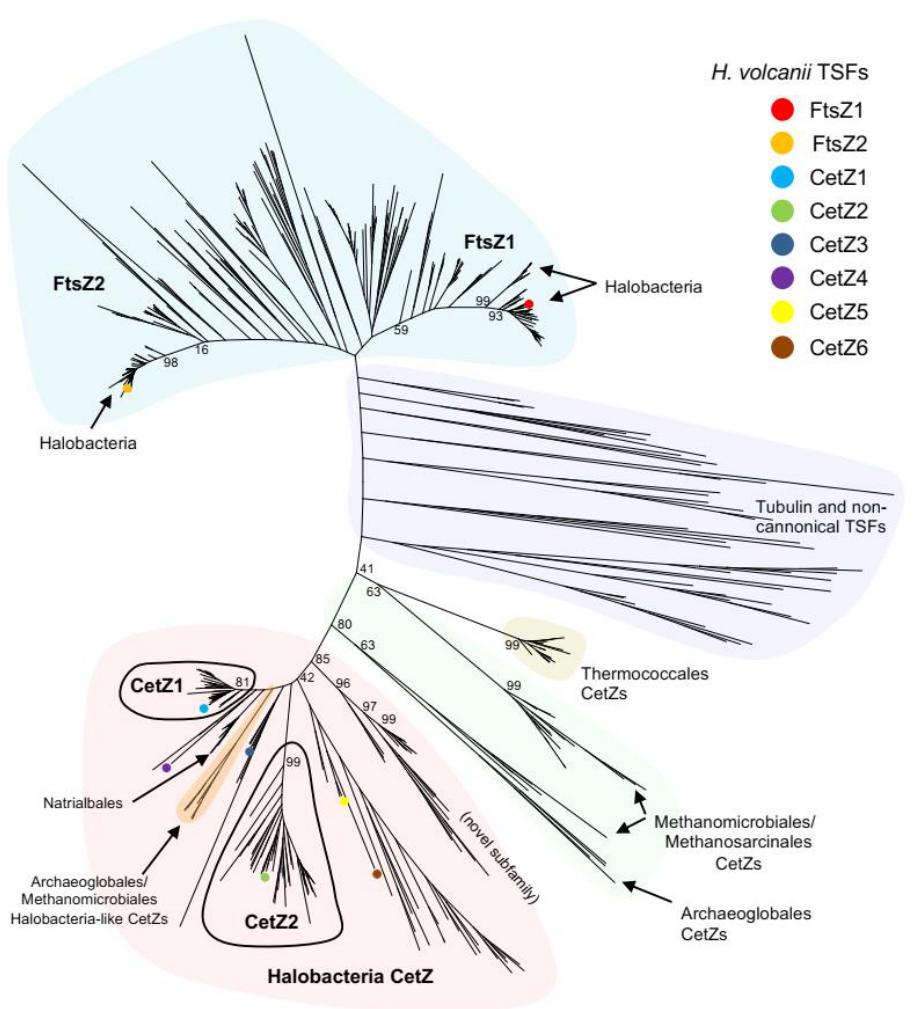
Figure 1. Phylogram of archaeal tubulin superfamily proteins; 550 identified tubulin superfamily protein sequences from 183 diverse archaea were aligned to generate the phylogram. Archaeal FtsZs are shaded in blue, while tubulin and non-canonical TSFs are shaded in purple. Four main groups of CetZs were identified: Halobacteria CetZs (red); Halobacteria-like CetZs from Archaeoglobales and Methanomicrobiales (orange); non-Halobacteria-like CetZs from Archaeoglobales, Methanomicrobiales, and Methanosarcinales (green); and CetZs from Thermococcales CetZs (yellow). Within Halobacteria, we define two important CetZ clusters, CetZ1 and CetZ2 (circled in black), by comparing bootstrap values from this phylogenetic analysis with unique residue identification (Section 3.5). Selected branch bootstrap percentages are shown.